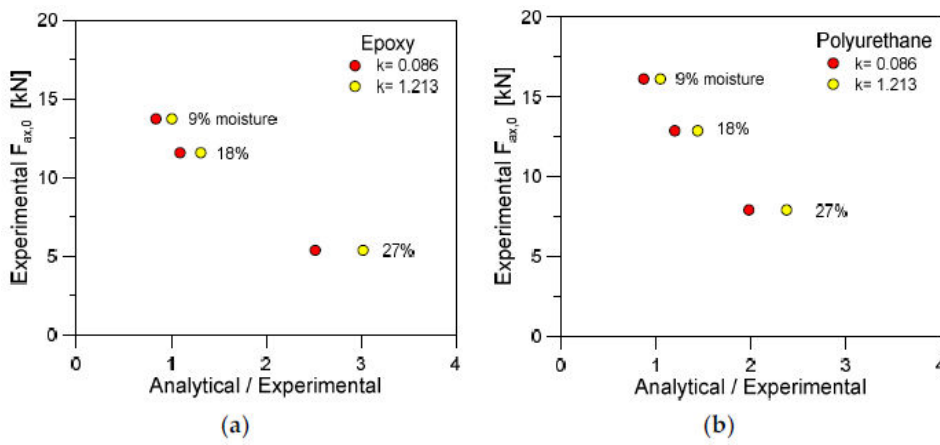
Figure 11. Average experimental failure load versus the ratio of analytical prediction, as obtained for specimens with ( a ) epoxy or ( b ) polyurethane adhesive and parallel rod-to-grain arrangement.